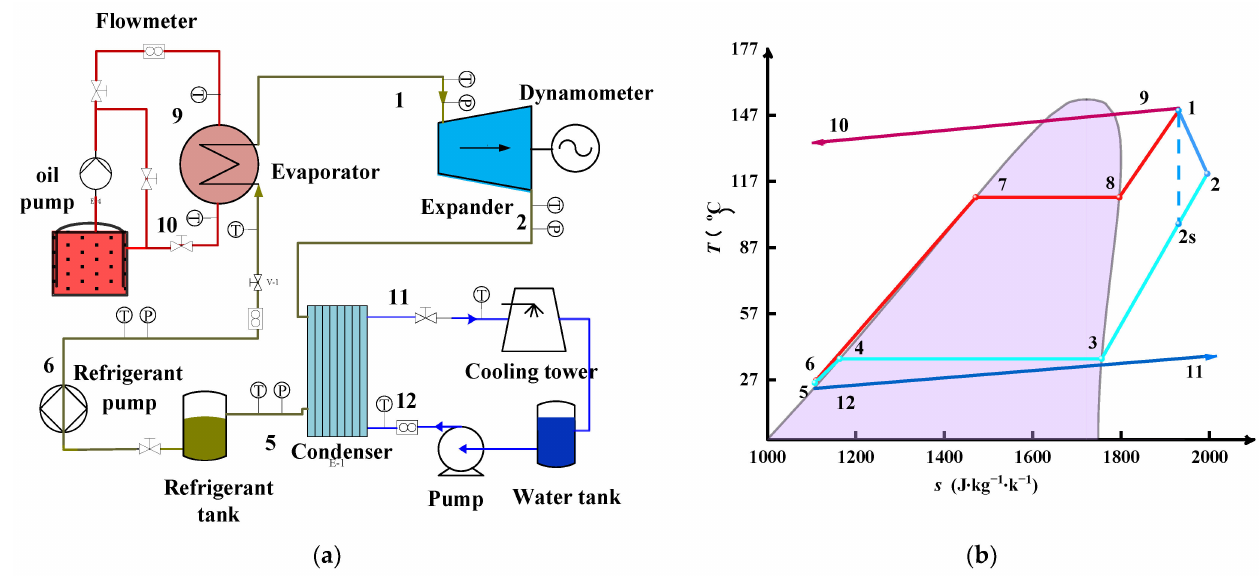
Figure 1. The ( a ) schematic diagram and ( b ) T-s diagram of the 4 kW ORC prototype.